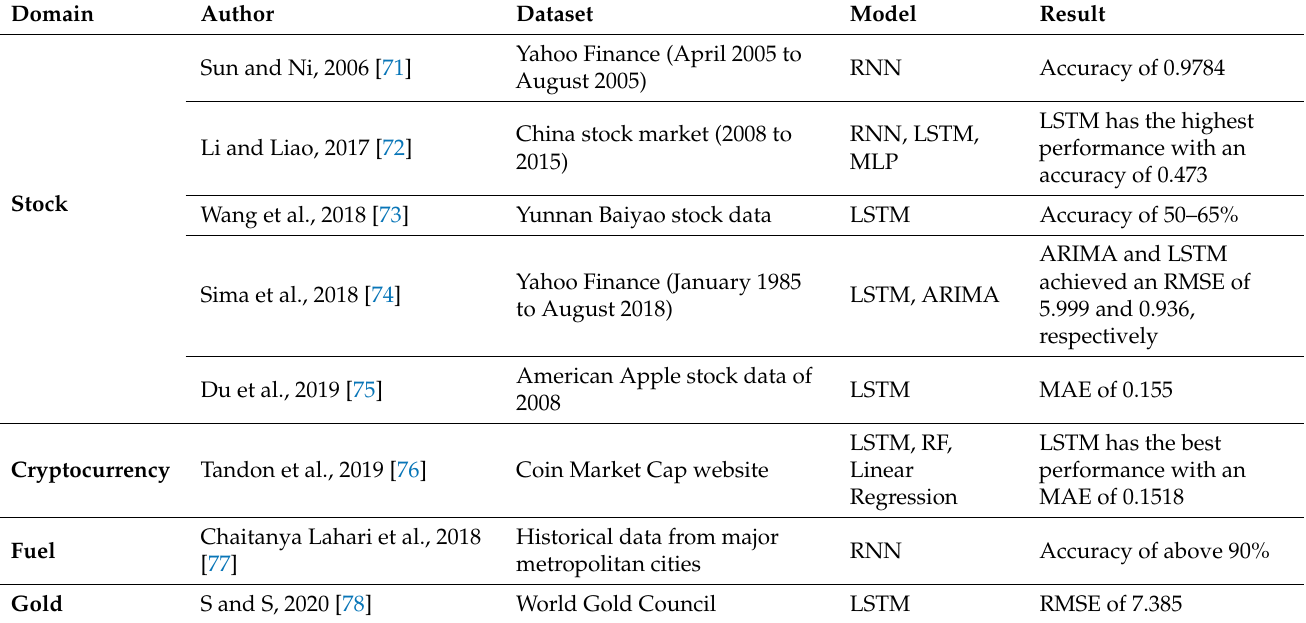
Table 8. RNN time-series forecasting from 2006 to